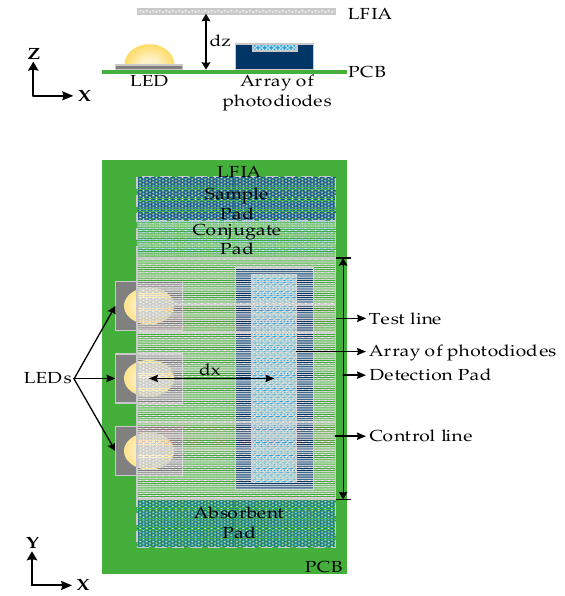
Figure 4. Simulation setup: plan and elevation (not to scale).